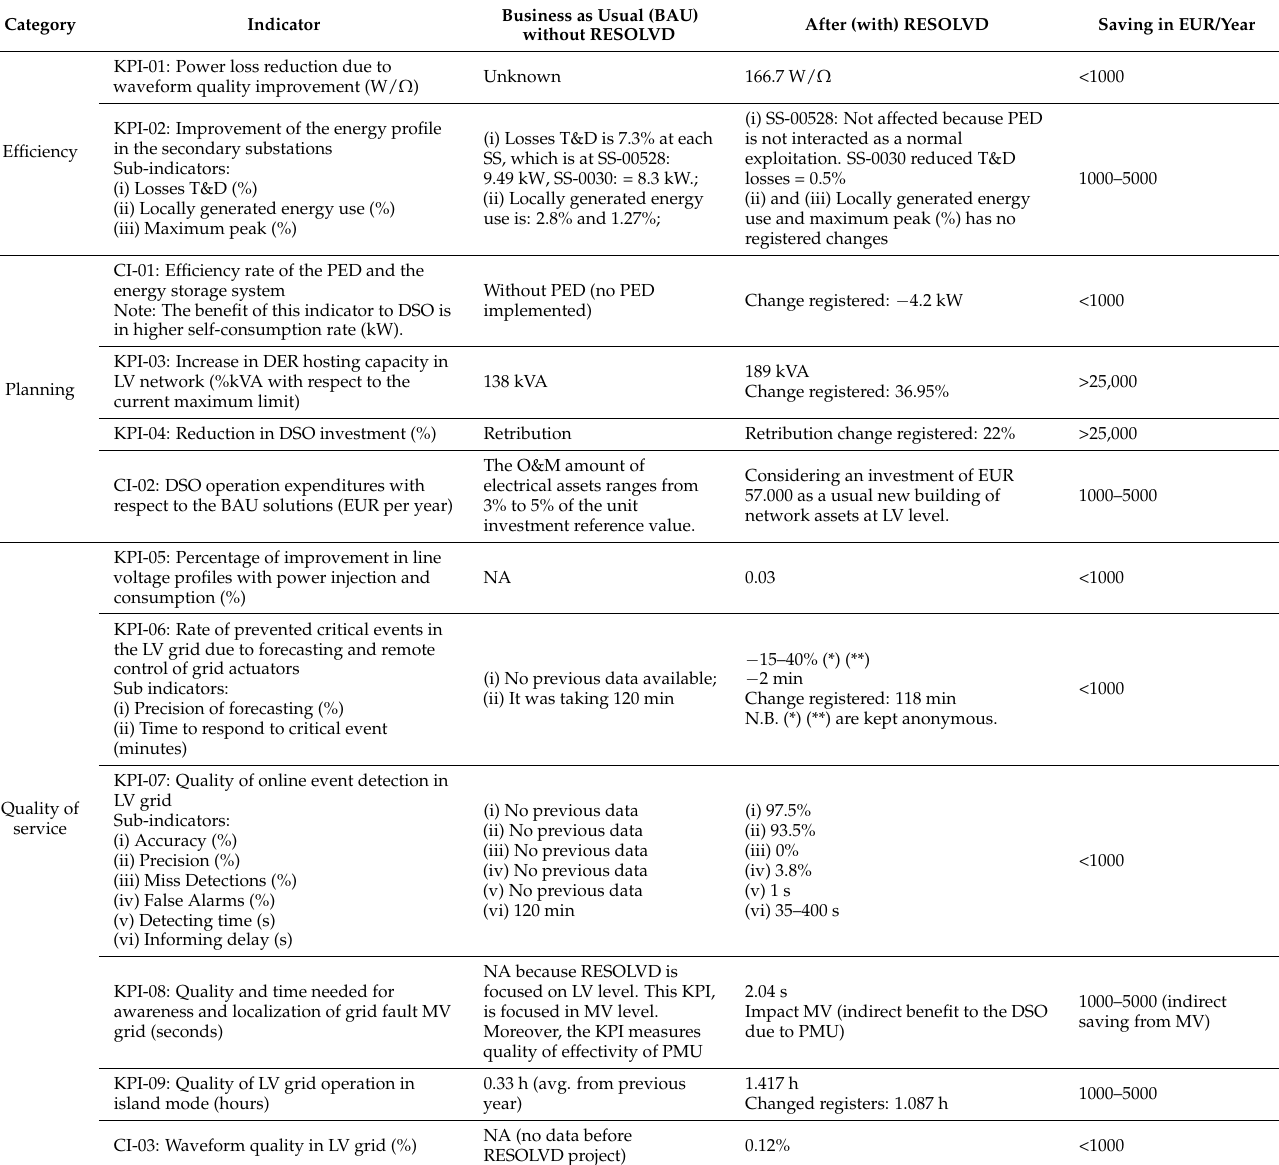
Table 3. Summary of quantified benefits from RESOLVD